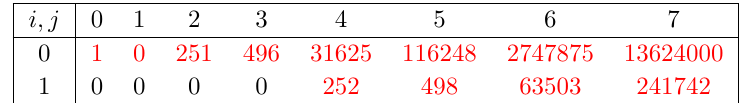
Table 19 . Series coe(cid:14)cients c E 8 for the unre(cid:12)ned elliptic genus of two E 8 instanton strings. i;j